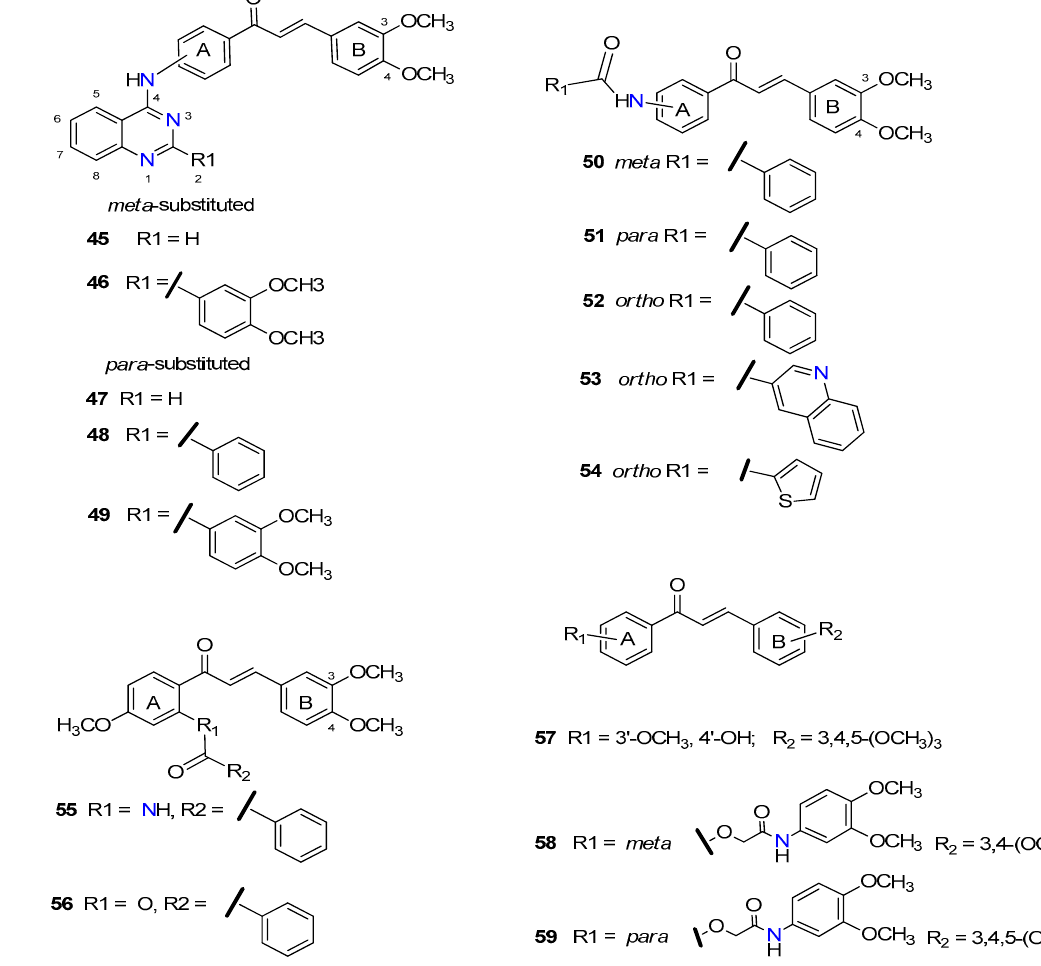
Figure 9. Chalcone derivatives 45 – 59 . Table 3. Inhibitory activities of compounds 45 – 59 against BCRP and P-gp as determined in the pheophorbide A and calcein AM assays.